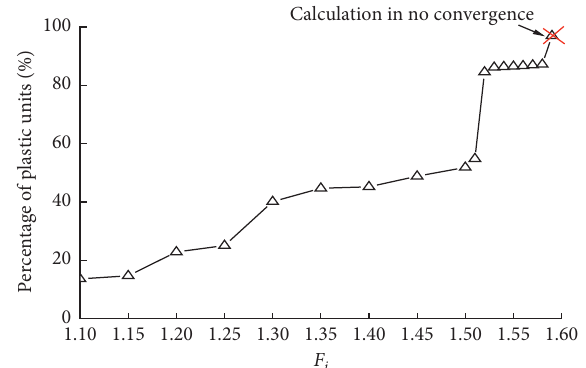
Figure 14: The evolution of the percentage of plastic units in the water-proof rock pillar with reduction factor.